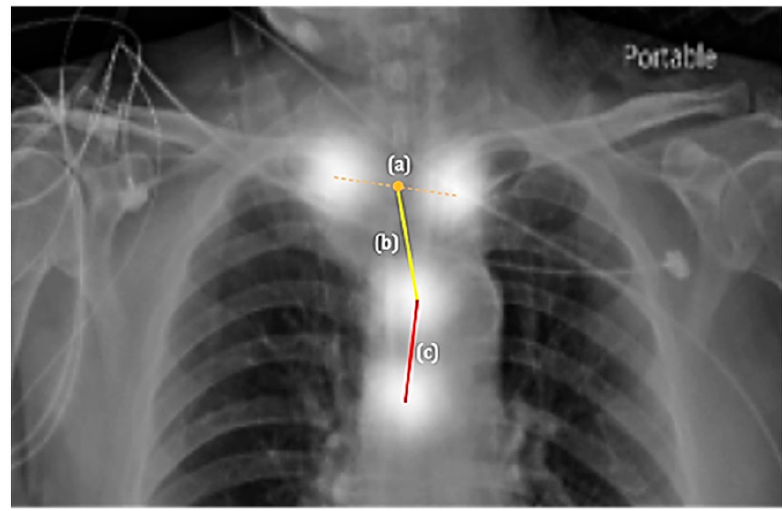
Figure 3. The estimated distances from key point predictions. ( a ) The midpoint of clavicular heads. ( b ) Tube-to-clavicle distance. ( c ) Tube-to-carina distance. Table 2. Appropriateness prediction performance based on tube-to-carina distance on the test dataset. N/A, not applicable. Distances are represented in millimeters (mm).